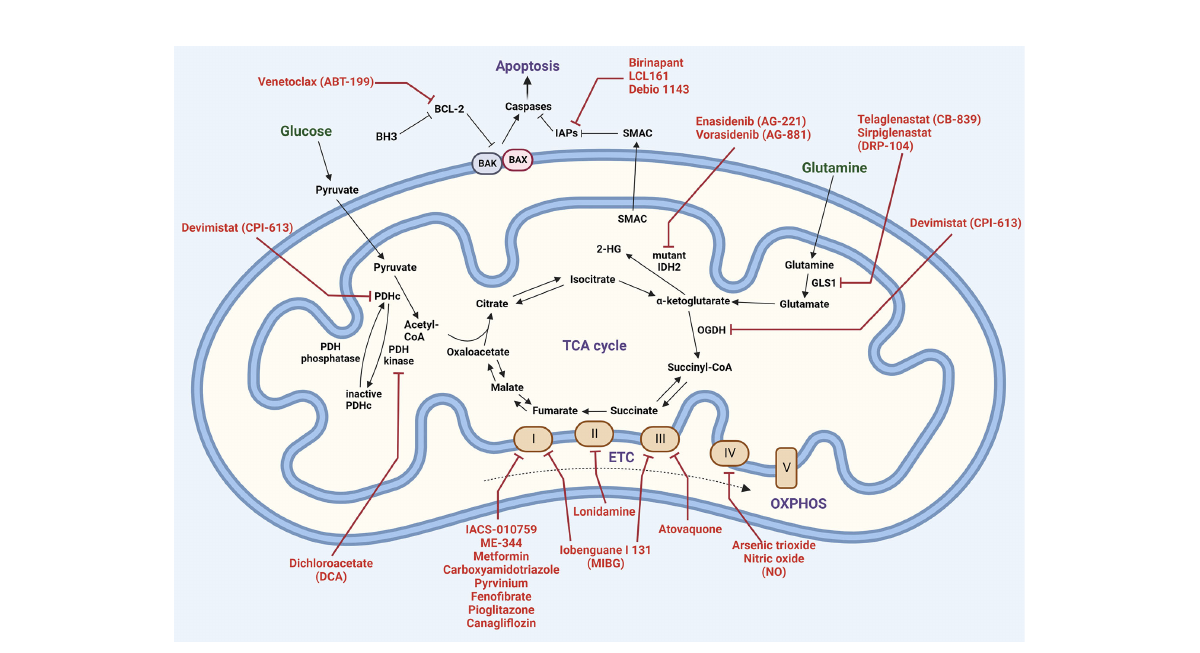
FIGURE 5 Mitochondrial therapeutic targets. Carbon metabolism (Krebs cycle and oxidative phosphorylation) and apoptosis pathways are shown, with inhibitors highlighted in red. Abbreviations: 2-hydroxyglutarate (2-HG); BCL-2 homologous antagonist killer (BAK); BCL-2-associated X protein (BAX); B-cell lymphoma 2 (BCL-2); BCL-2 homology domain 3 (BH3); glutaminase1 (GLS1); inhibitor of apoptosis (IAP); isocitrate dehydrogenase 2 (IDH2); alpha-ketoglutarate dehydrogenase (OGDH); pyruvate dehydrogenase complex (PDHc); second mitochondria-derived activator of caspases